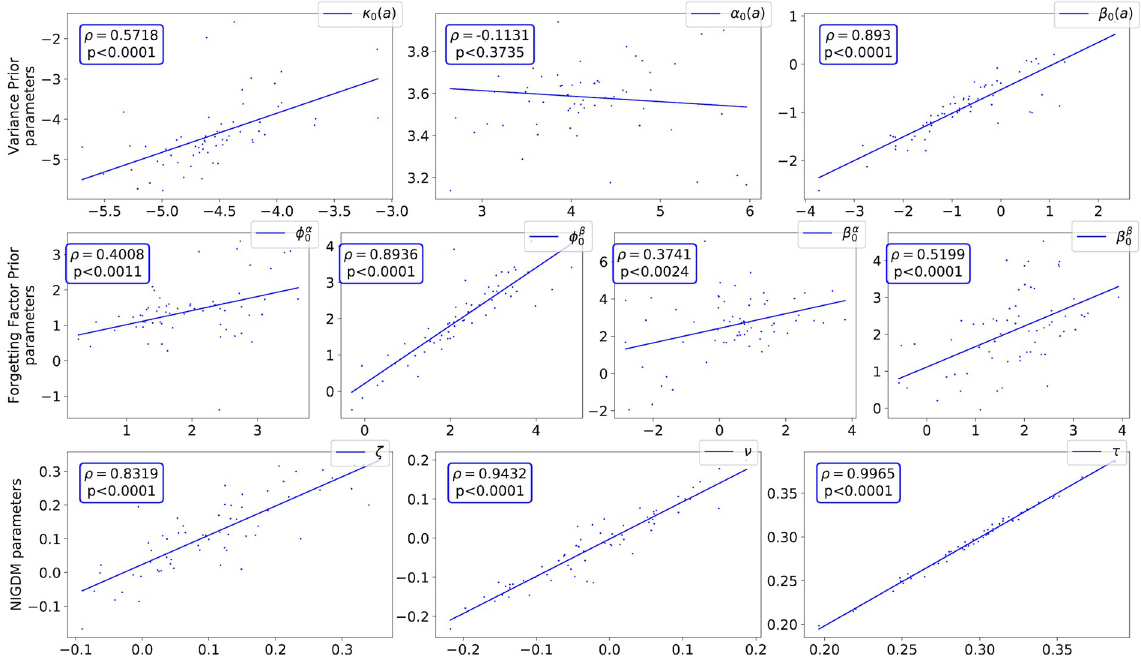
Fig 8. Correlation between the true (x axis) and the posterior estimate (y axis) of the parameters of the prior distributions across subjects. The first row displays the correlations between true value and estimated θ 0 . The second row focuses on ϕ 0 and β 0 , whereas the third row shows the correlations for the NIGDM parameters (threshold, relative start-point and non-decision time). Correlation coefficients and associated p- value (with respect to the posterior expected value) are displayed in blue boxes. All parameters are displayed in the unbounded space they were generated from. Overall, all parameters correlated well with their true value, except for the α 0 ( a